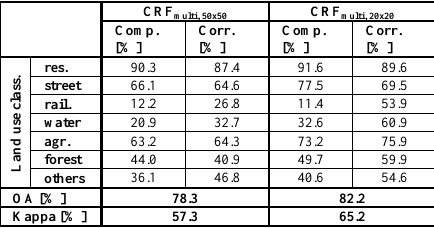
Table 3: Overall accuracy [%], kappa index [%], completeness (comp.) and correctness (corr.) values [%] for the land use classes res. , street , rail. , water , agr. , forest and others obtained by classification applying the two-layer CRF approach based on superpixels of size 50 x 50 (CRF multi, 50x50 ) and of size 20 x 20 (CRF multi, 20x20